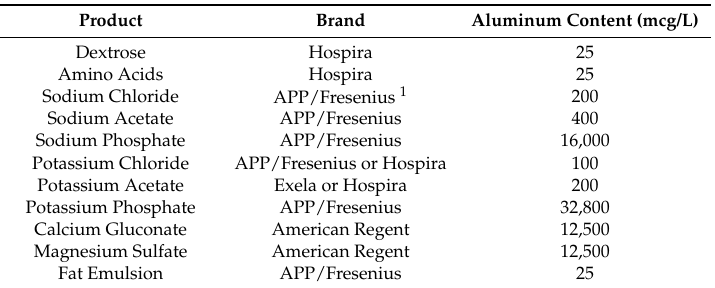
Table 1. Manufacturer Aluminum